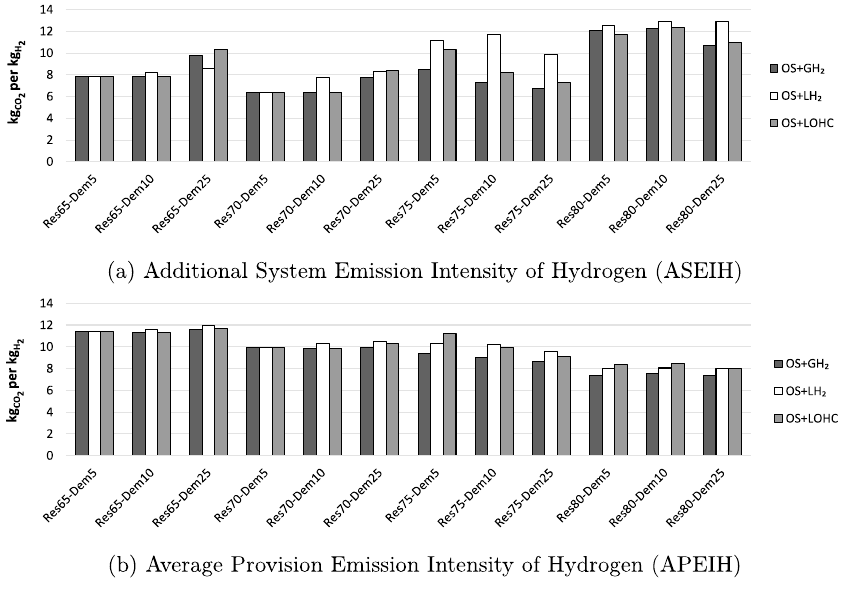
Figure 7. Emission